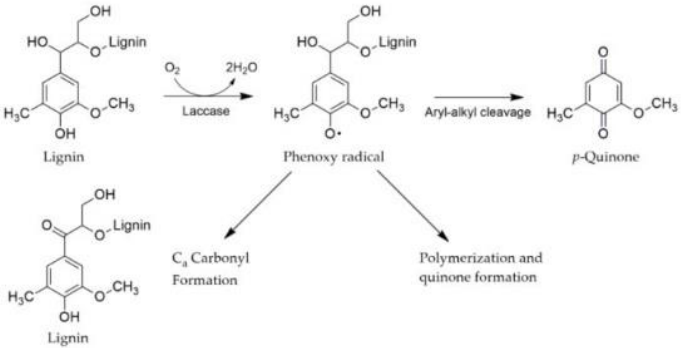
Figure 1. Reaction of laccase on phenols oxidation [10].